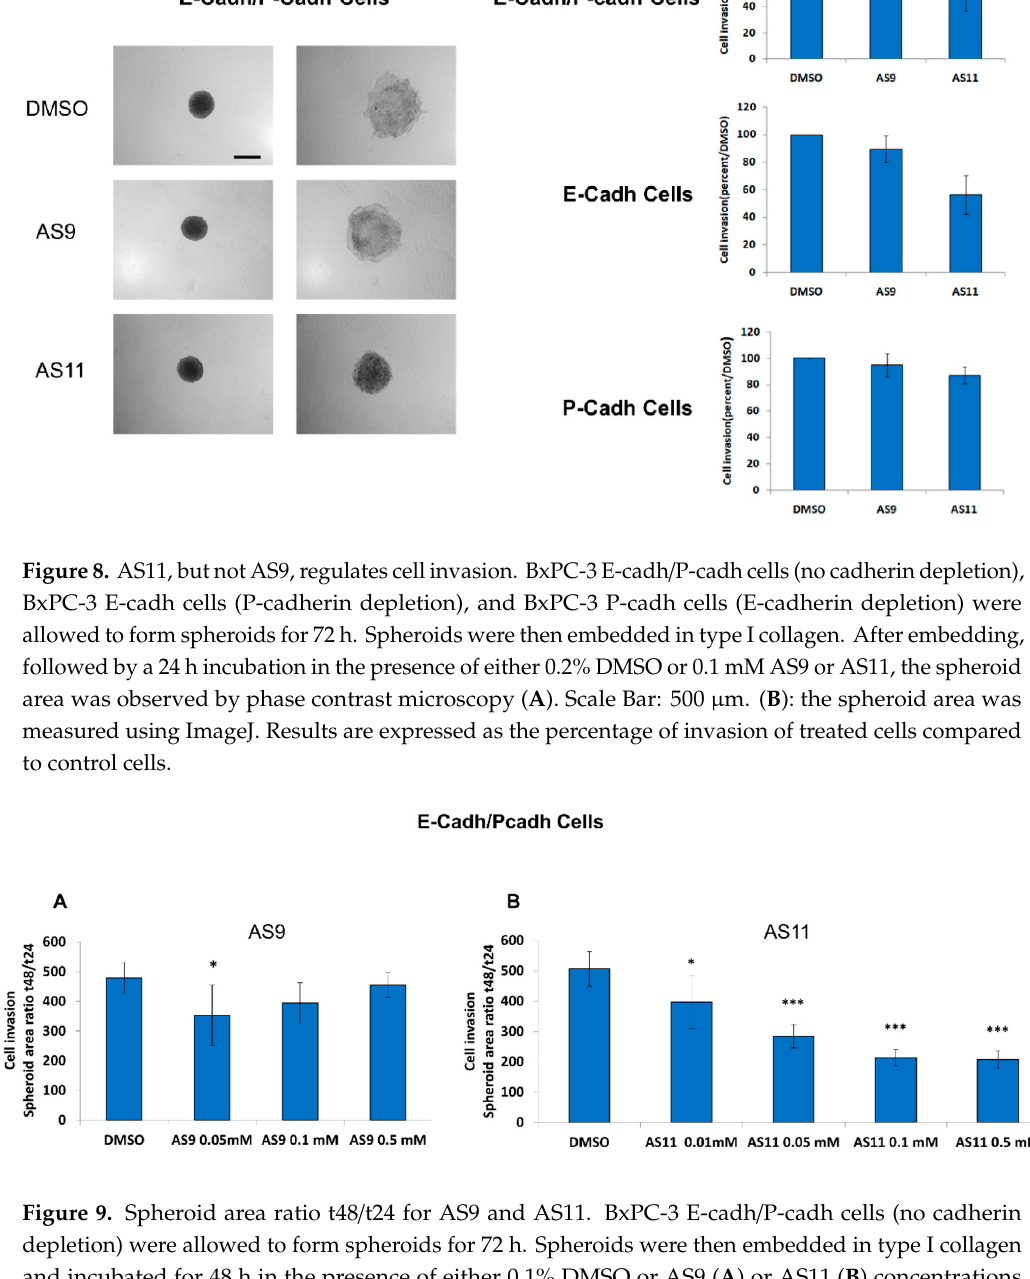
Figure 9. Spheroid area ratio t48/t24 for AS9 and AS11. BxPC-3 E-cadh/P-cadh cells (no cadherin depletion) were allowed to form spheroids for 72 h. Spheroids were then embedded in type I collagen and incubated for 48 h in the presence of either 0.1% DMSO or AS9 ( A ) or AS11 ( B ) concentrations ranging from 0.01 to 0.5 mM. The spheroid area was observed by phase-contrast microscopy and measured after 24 and 48 h incubation. See the Materials and Methods section for details on the statistical analysis. A p < 0.05 was considered statistically significant and is indicated by ‘***’ when p < 0.001 and ‘*’ when p < 0.05.